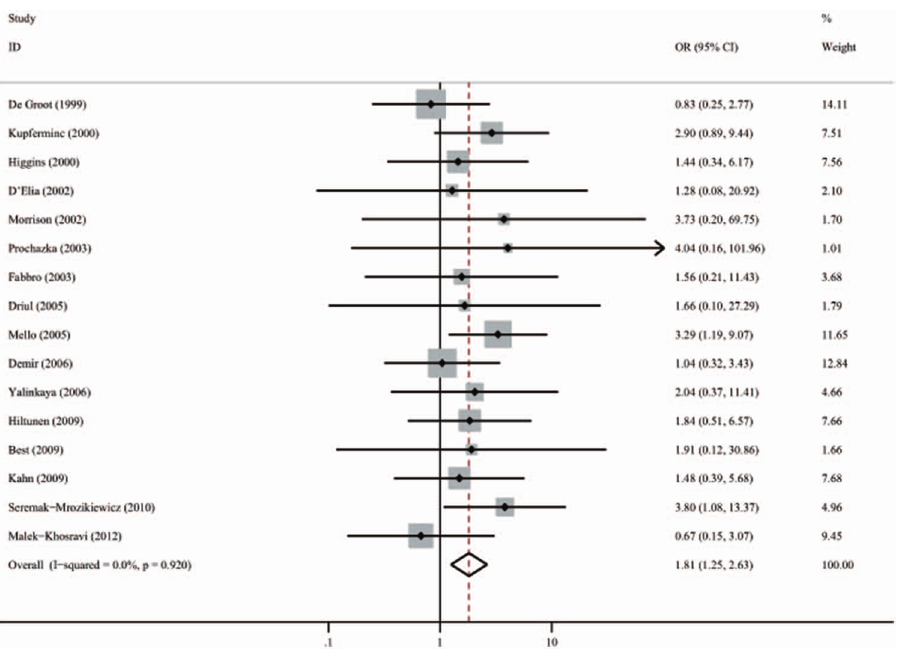
Figure 2. Forest plot of OR with 95%CI of all preeclampsia associated with the prothrombin G20210A polymorphism by fixed model. Black square means value of OR, and the size of the square means inversely proportional to its variance. Horizontal line means 95% confience interval (CI) of OR. Black diamond means pooled results.